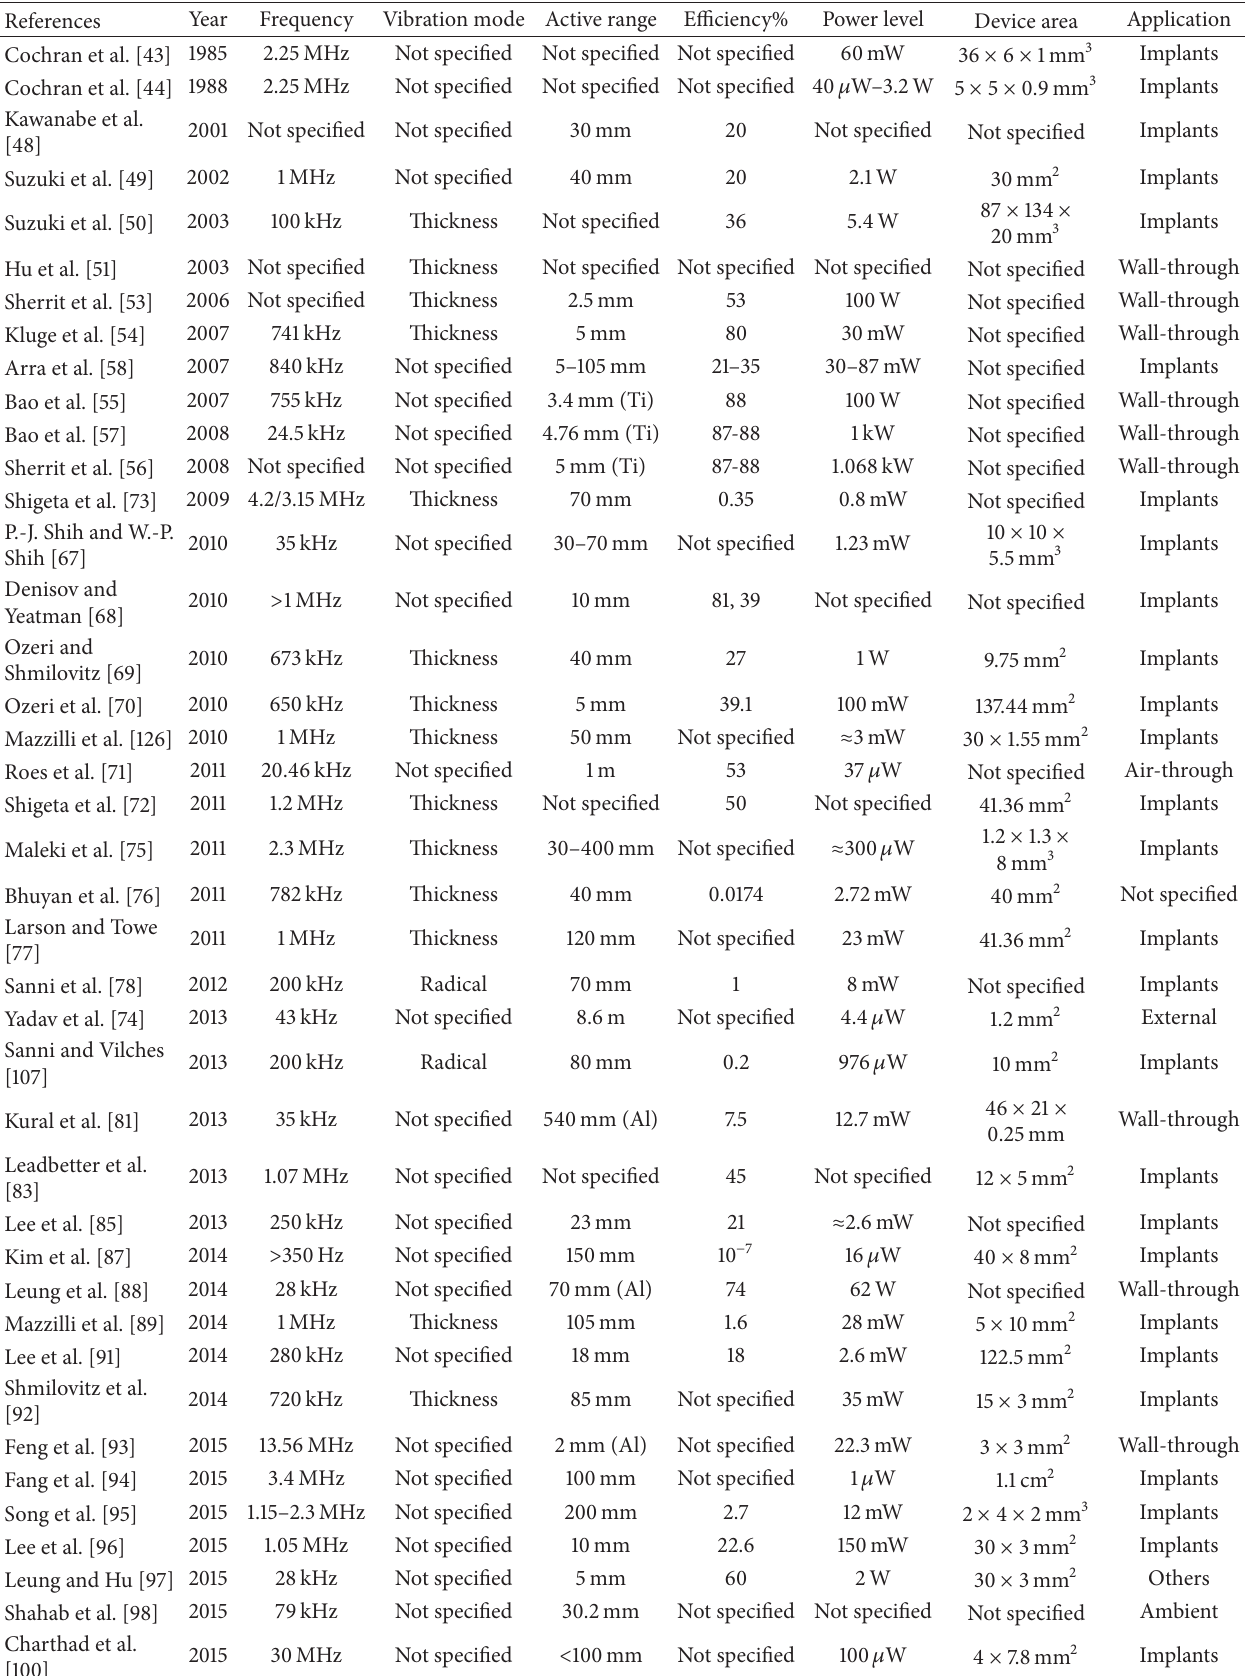
Table 1: Deployment of the existing AET